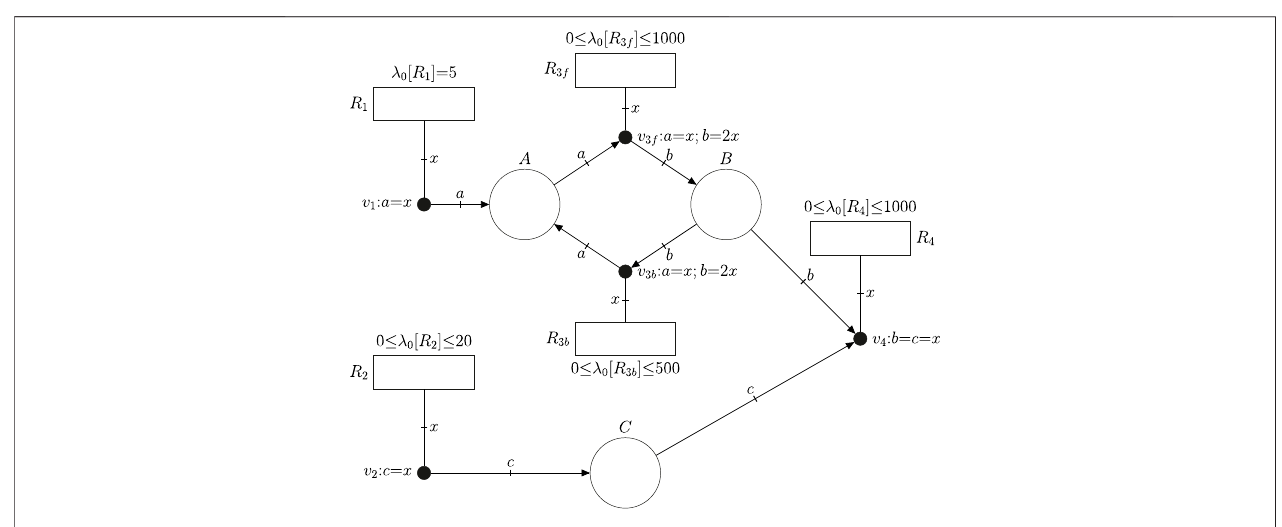
FIGURE2| FNmodelingtheconstraintbasedmodelexpressedbythereactionsin Table1 .The fl uxboundsofthereactionsaremodeledbythedefaultintensities (or speeds) λ 0 of transitions. Reversible reactions like R 3 are unfolded into a forward and a backward reaction with non-negative fl ux.